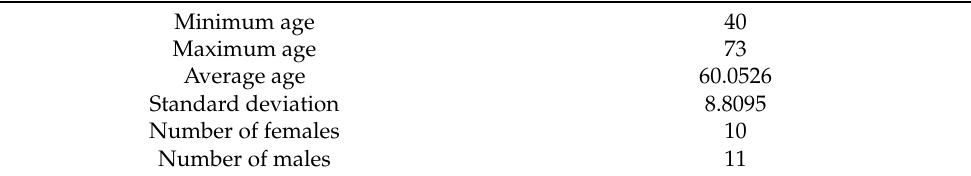
Table 3. Baseline characteristics of the 21 Hungarian patients involved in the